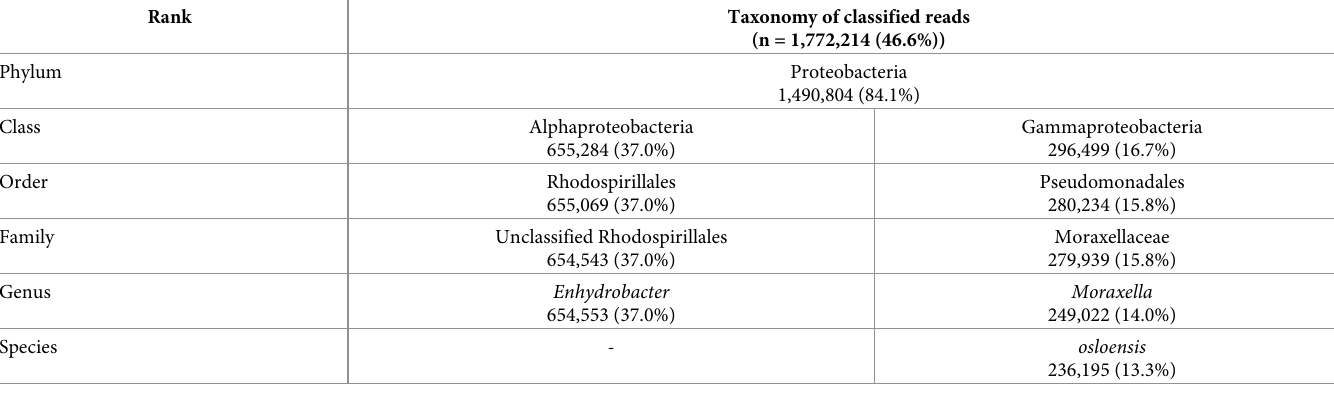
Table 4. Details of One Codex analysis of taxonomic grouping for classified reads from isolate NA45737 � .